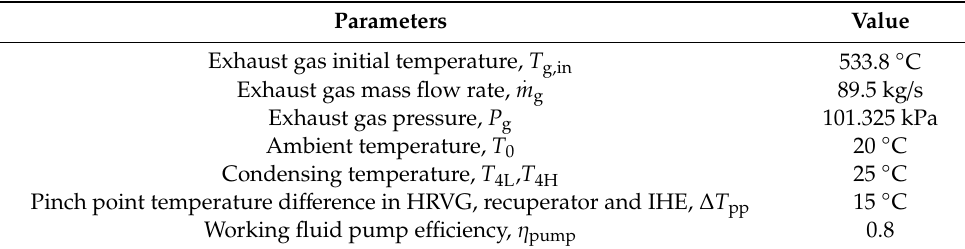
Table 4. Specified parameters of the combined system.